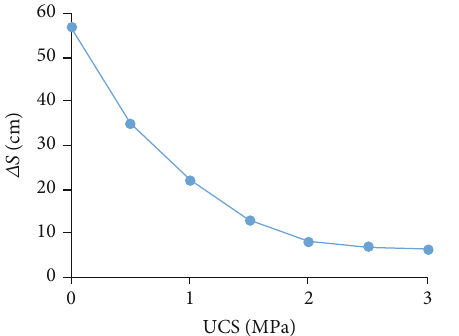
Figure 15: Shrinkage Δ S of front column versus back fi ll